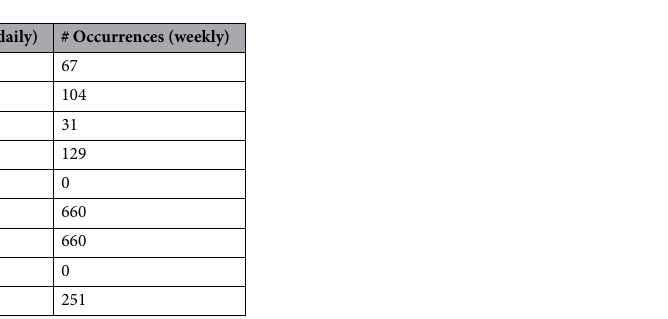
Figure 8. Candlestick plots of new COVID cases in Japan (first case: 2020/01/14), Korea (first case: 2020/01/19) and the UK (first case: 2020/02/01). Below each plot is the associated MACD chart. A bullish MACD cross-over involves the (red) MACD curve crossing the (green) Signal curve from below, this predicts a rise in cases in the near-term. These examples support that the MACD analysis can provide useful information regarding the evolution of the pandemic.